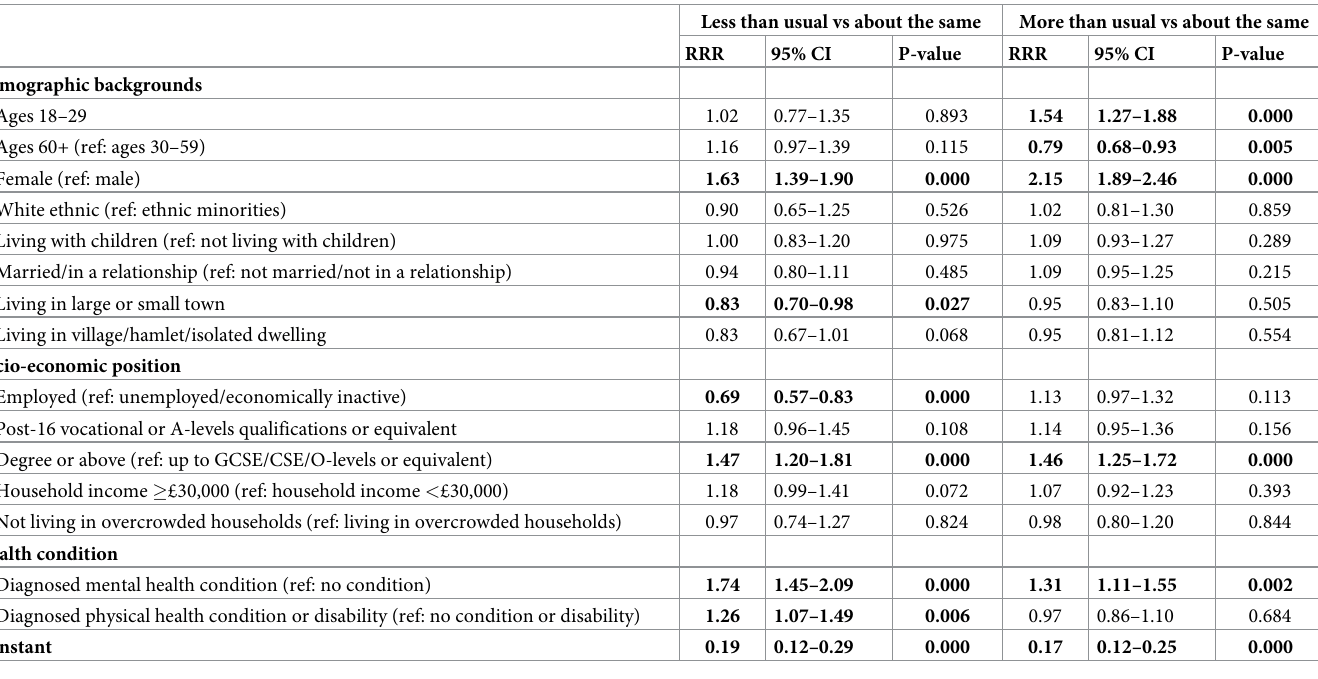
Table 2. Multinomial logistic regressions comparing arts engagements in the first lockdown (April/May 2020) with engagements in pre-pandemic periods (N = 23,086).